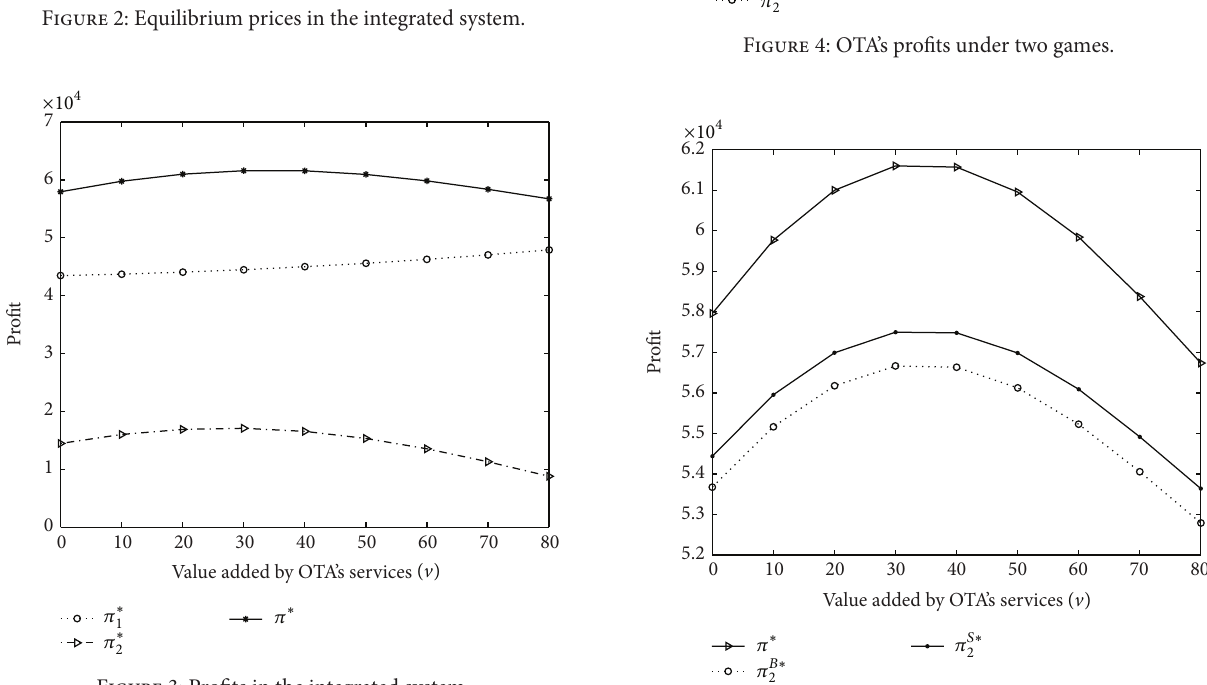
Figure 3: Profits in the integrated system.